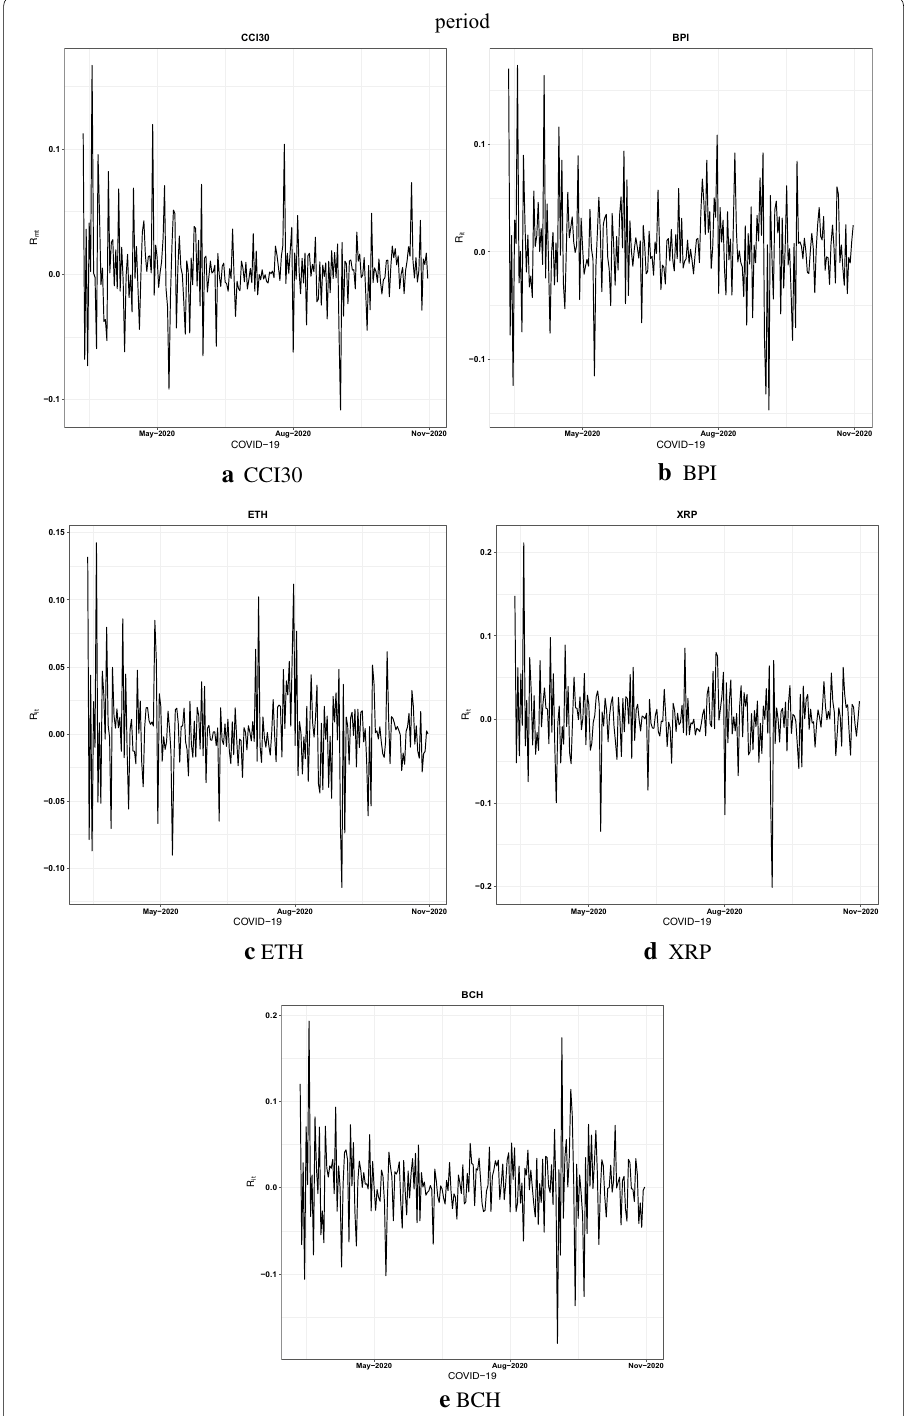
Fig. 2 Time series plots of the CCI30 and four cryptocurrencies’ returns during the COVID-19